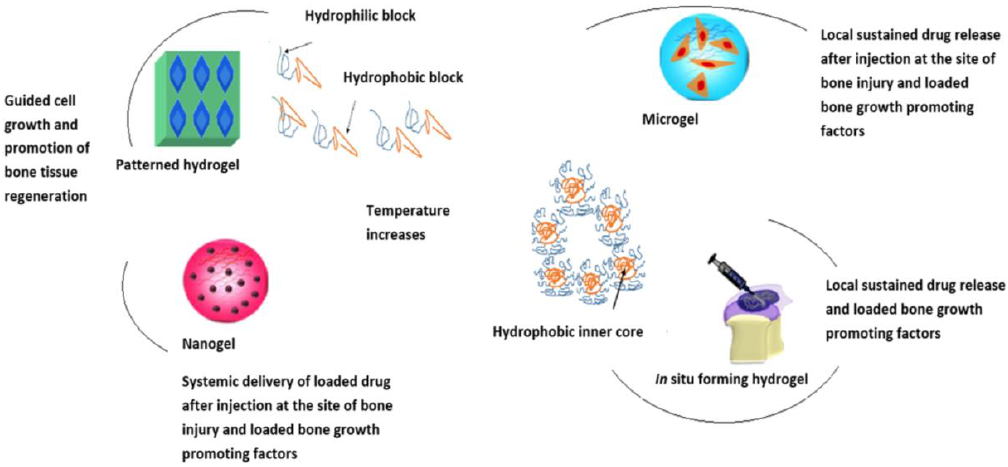
Figure 2. Physical gelation system derived from increased temperature due to interaction of hydrophilic and hydrophobic blocks for promoting an amphiphilic polymer.